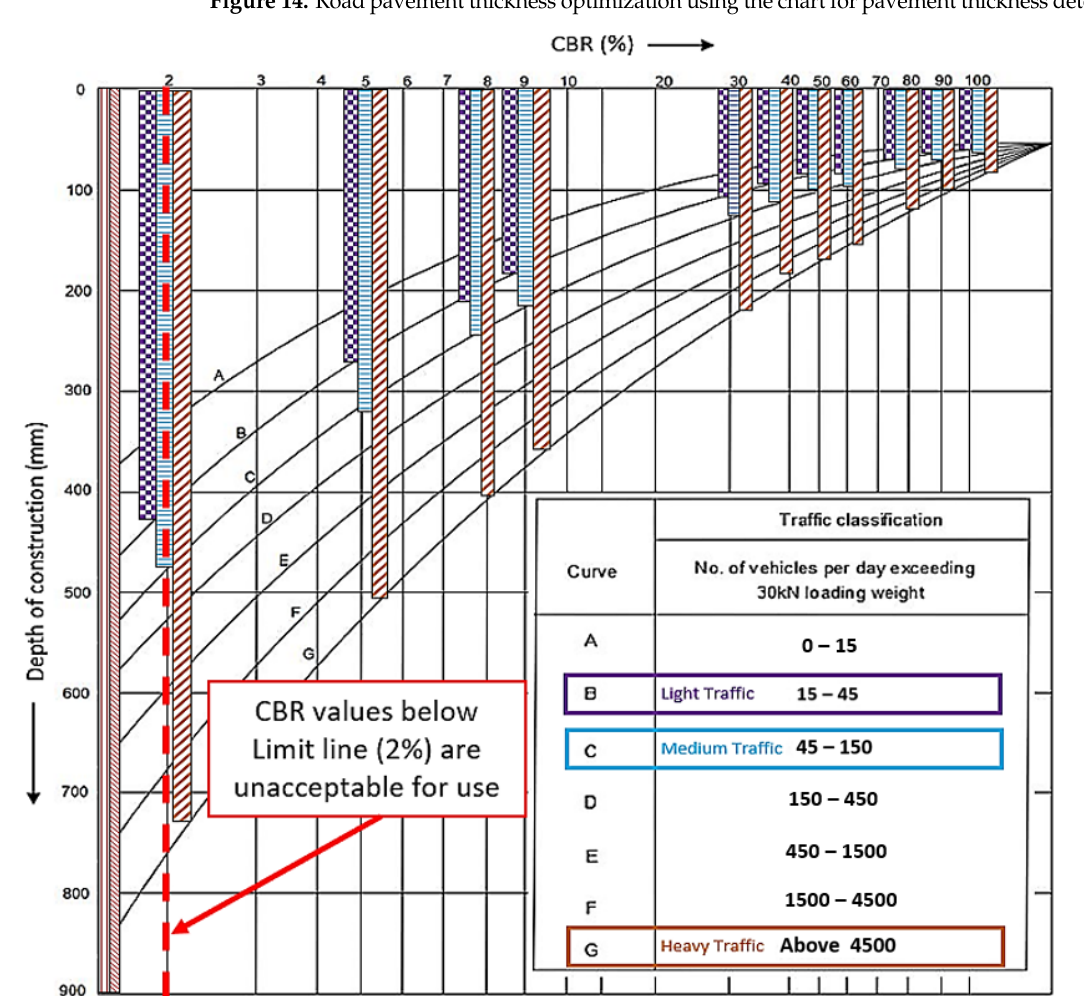
Figure 15. Pavement depths determination using the chart for construction depth determination.